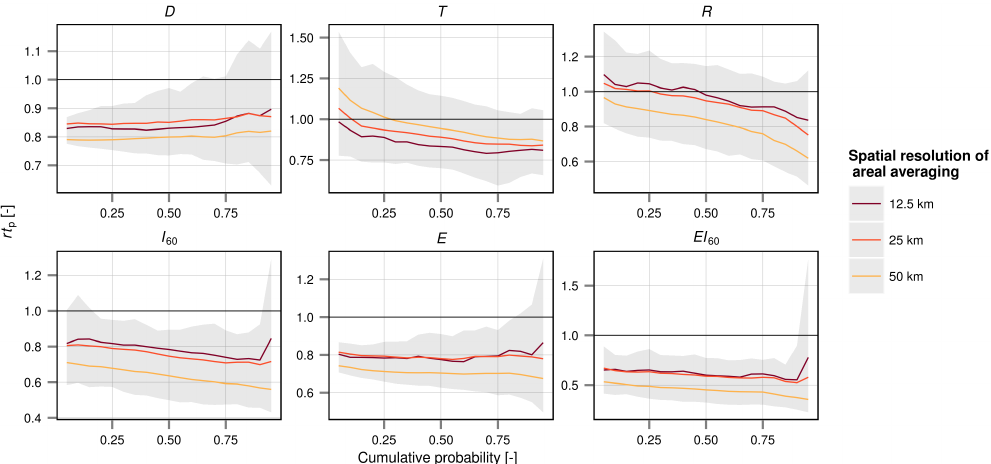
Figure 2. Quantile ratios rt p for the distribution of the area-average and at-site rainfall event characteristics ( D , T , R , I 60 , E , EI 60 ). For each spatial resolution (12.5, 25, 50km), the average from all neighbourhoods is indicated by a solid line. Envelopes of rt p for all neighbourhoods (grey areas) represent the maximum range between the 5th and 95th quantiles for the three considered spatial